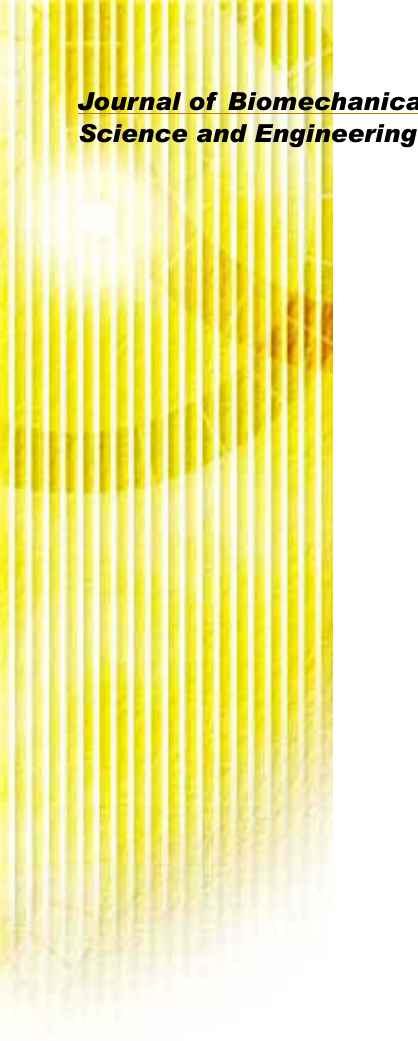
Figure 3. The 3-link dynamical model consisting of 3 rigid parts: feet, lower limbs (excluding feet), and the rest of body (head, arms, and trunk; HAT), jointed at the ankle and hip. External and internal forces, as well as the control inputs (ankle & hip torque) are shown by red